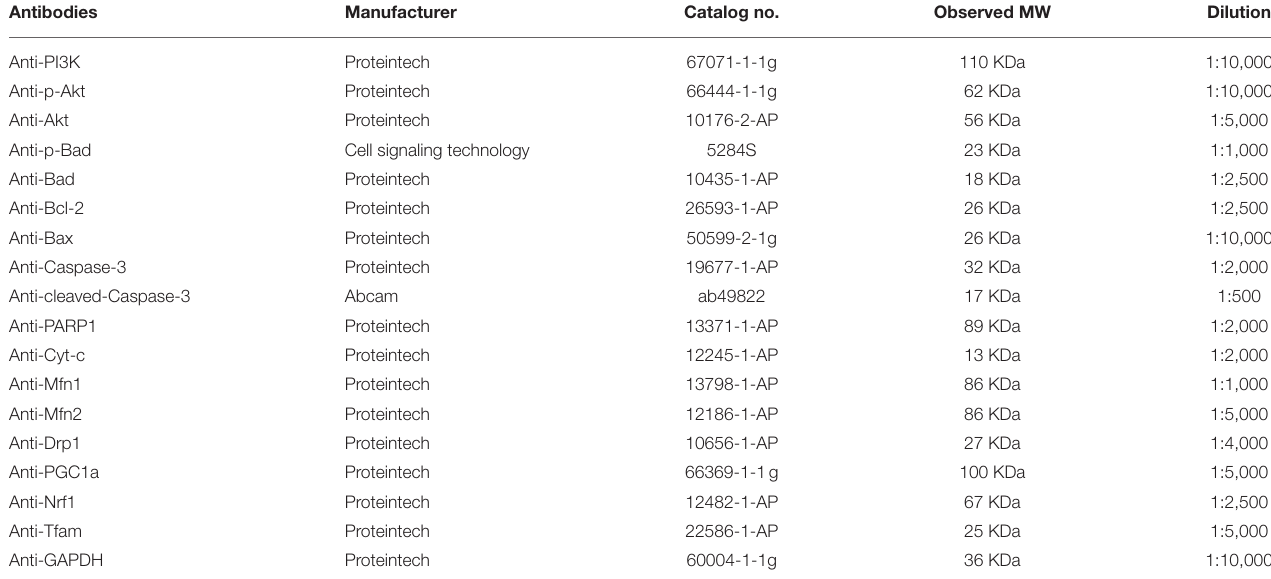
TABLE 3 | Antibodies used in the